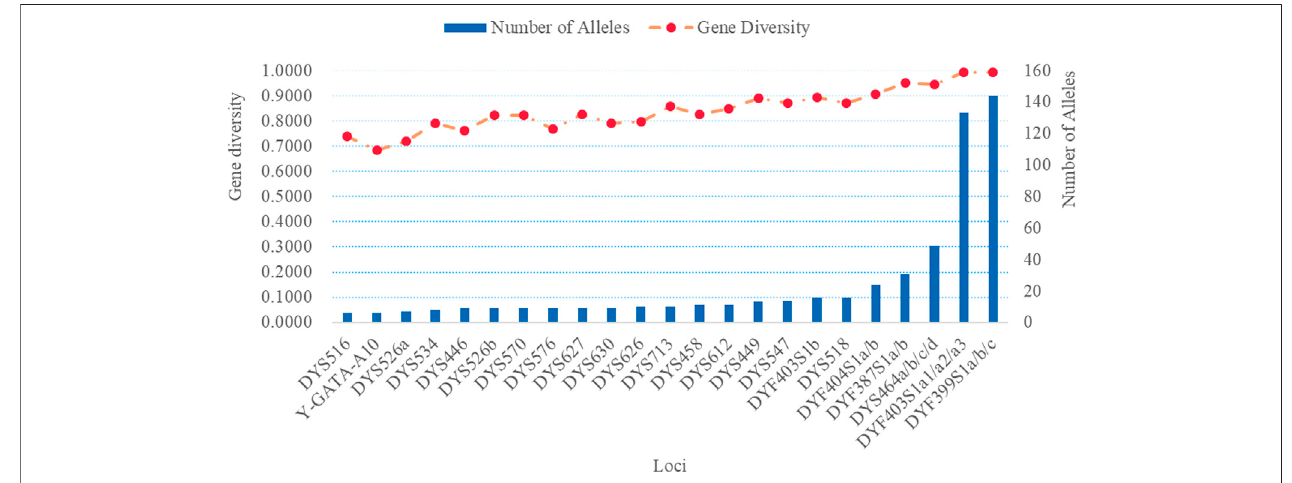
FIGURE 5 | The number of alleles and gene diversities of 32 RM Y-STRs in the Guizhou Han population.